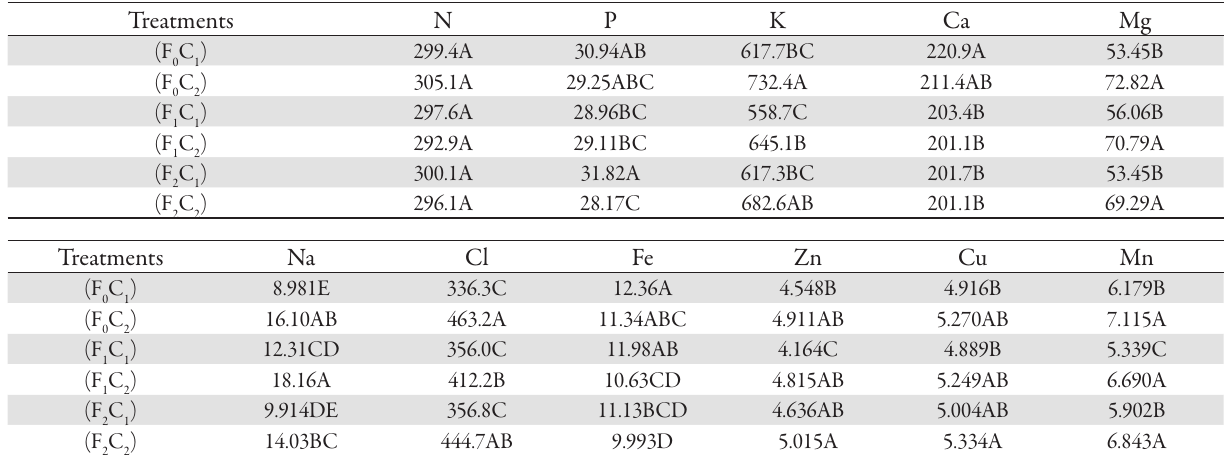
Tab. 6. The comparison of mean for the interaction effect between fungus and cultivar on uptake of macro and micro elements and elements of Na and Cl (mg pot -1